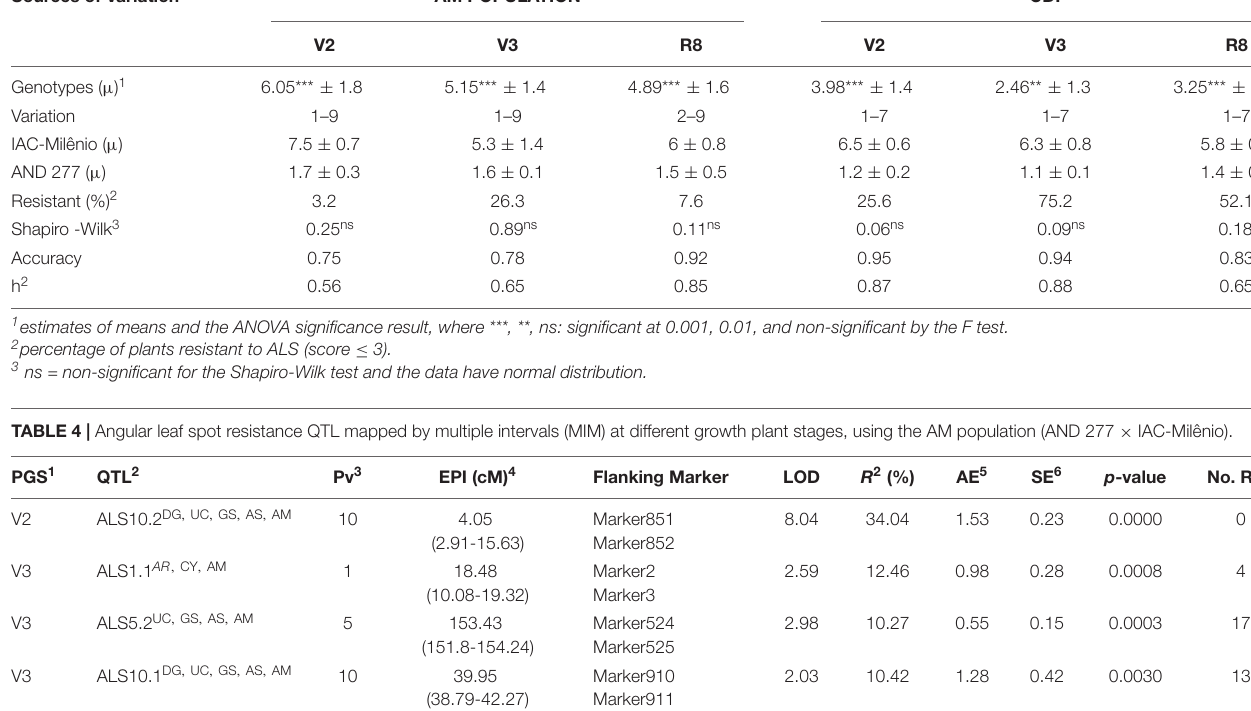
TABLE 3 | Estimates of means, standard deviations, percentage of resistance, normality test, experimental accuracy, and broad-sense heritability for angular leaf spot resistance evaluations in the V2, V3, and R8 stages using the AM population and the carioca diversity panel. Sources of Variation AM POPULATION CDP